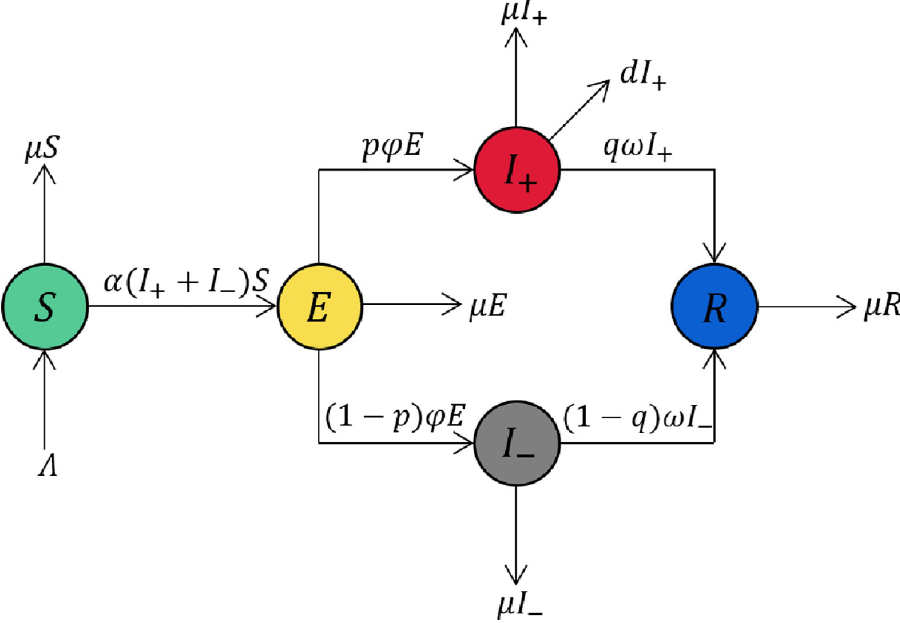
Fig 1. The flow of the